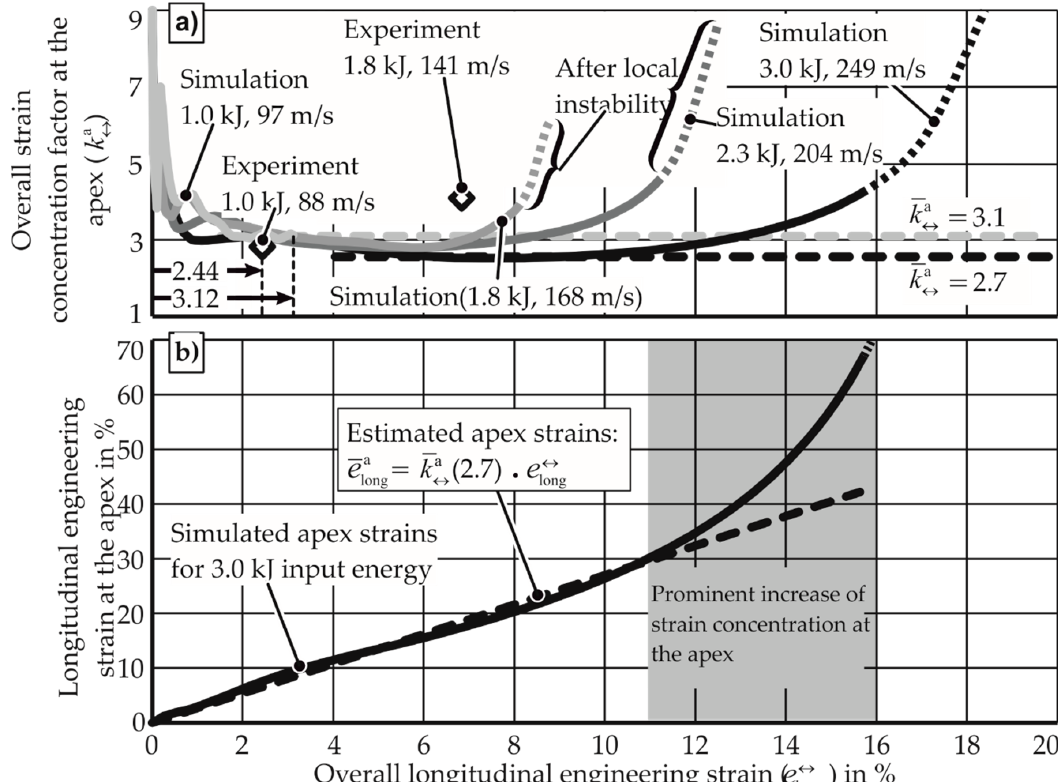
Figure 22. Electromagnetic forming limit tests with AW-5083 under uniaxial tension. ( a ) Strain concentration at the apex, ( b ) strain at the apex. kJ values give the input energy of the experiment, m/s values give the maximum apex velocity.